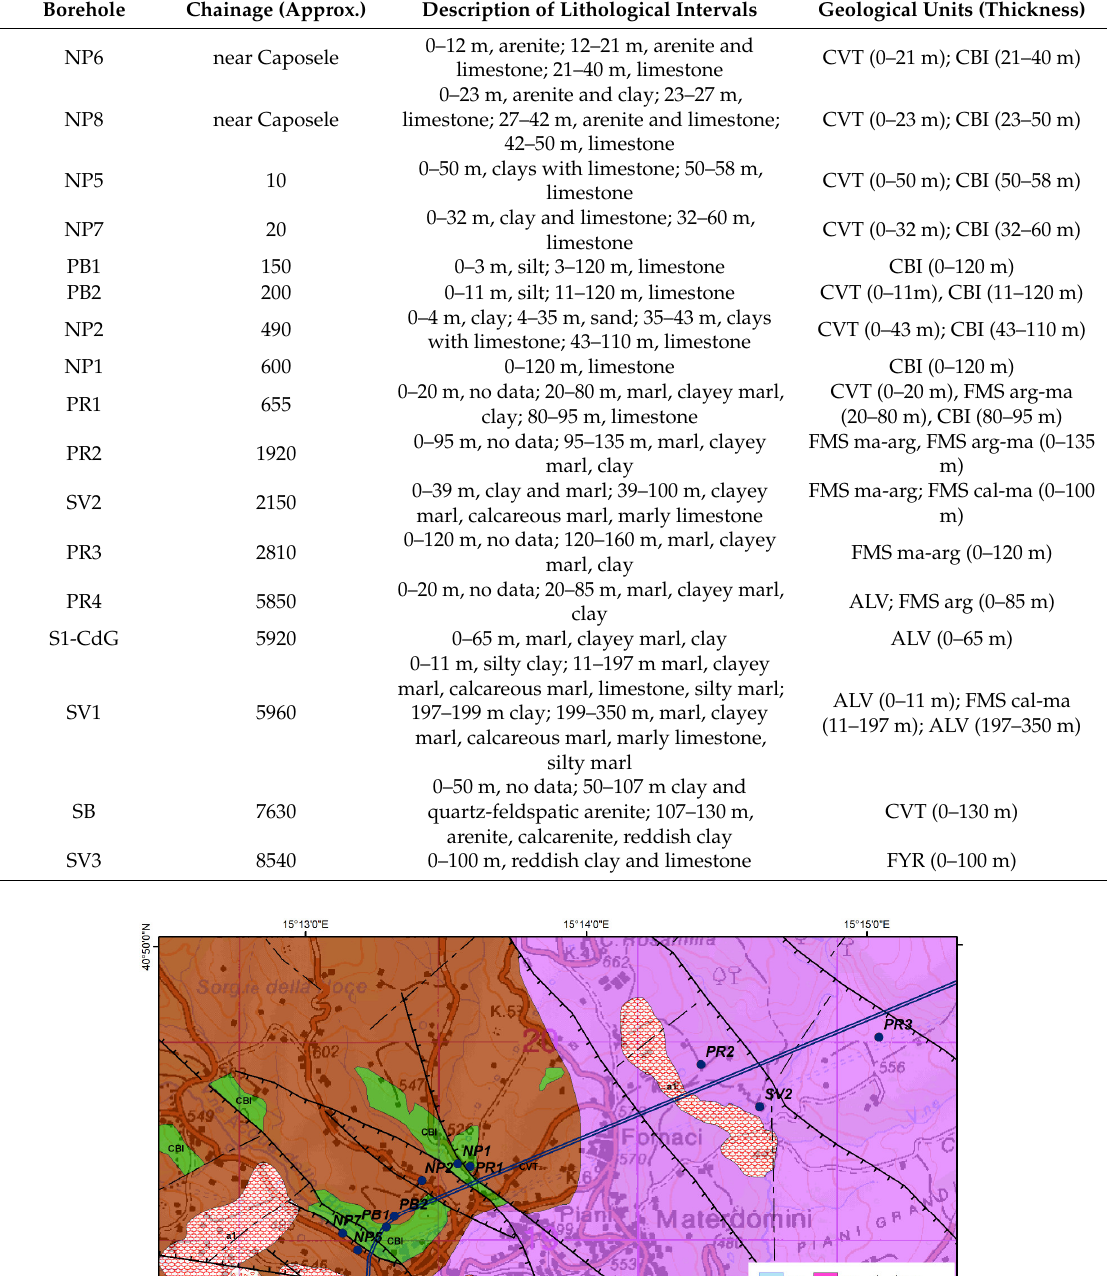
Table 2. Borehole stratigraphy data available in the study area. For unit codes see Table 1 caption.